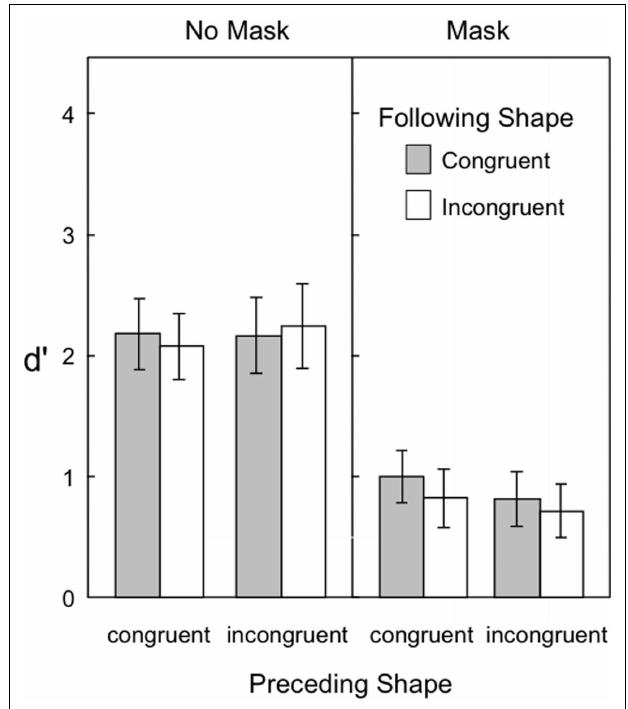
FIGURE 5 |Visibility of the target in Experiment 3, as indexed by d (cid:48) in a shape detection task. Error bars represent ± 1 SEM.